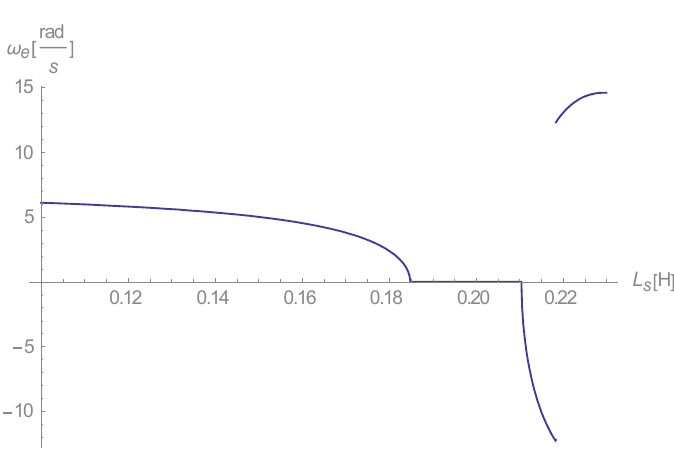
Figure 9. Plot of the imaginary part of the third solution of ω e (L S ).